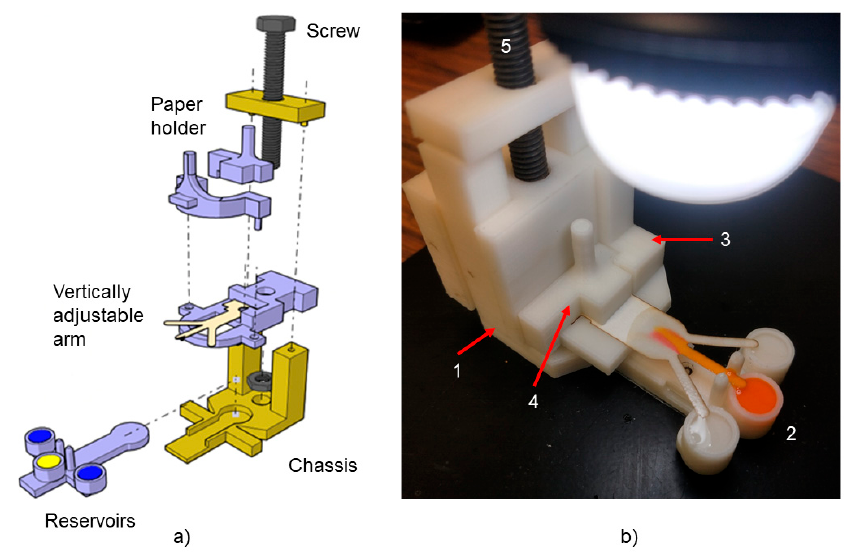
Figure 3. 3D-printed support. ( a ) Assembly of the different parts. ( b ) Picture of a test under perfor-